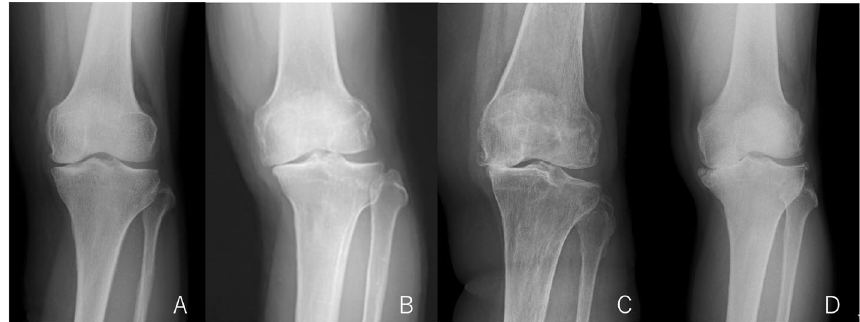
Fig. 1 Ahlbäck radiographic classification grade